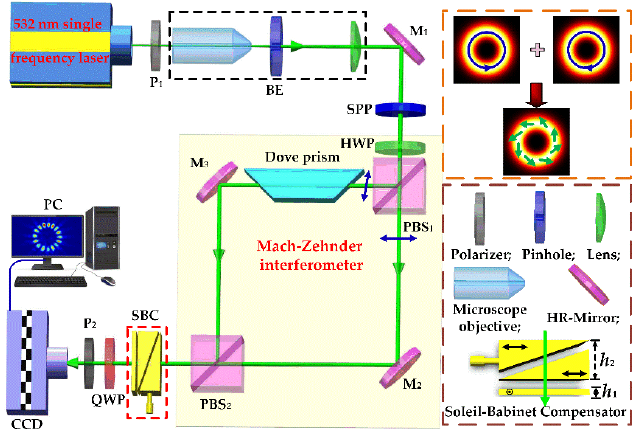
Figure 2. Schematic of the experimental setup. A half-wave plate (HWP) with its fast axis oriented at an angle β with respect to x - axis is inserted behind the SPP to adjust the polarization of the vortex beam. After passing through the HWP, the Jones vector of the vortex beam is converted into β φ β φ [cos(2 )exp( ), sin(2 )exp( )] T il il . Then, the linearly polarized vortex beam is split into horizontally and vertically polarized vortex beams via a polarizing beam splitter (PBS 1 ),